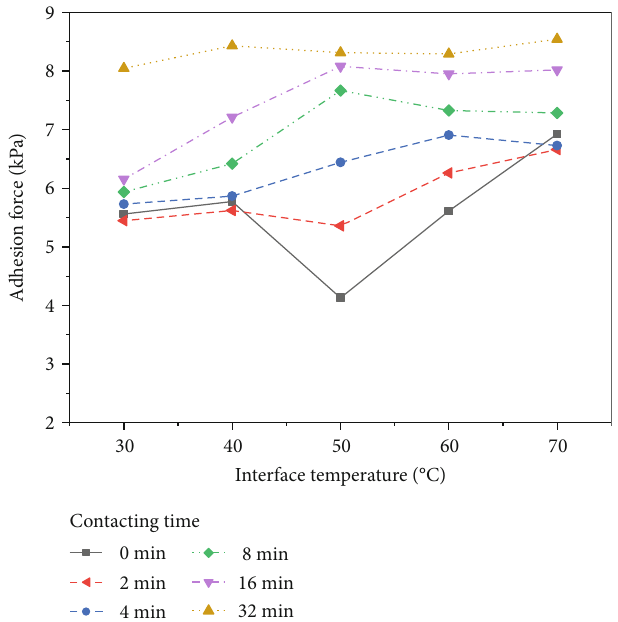
Figure 8: The adhesion force changes with interface temperature.